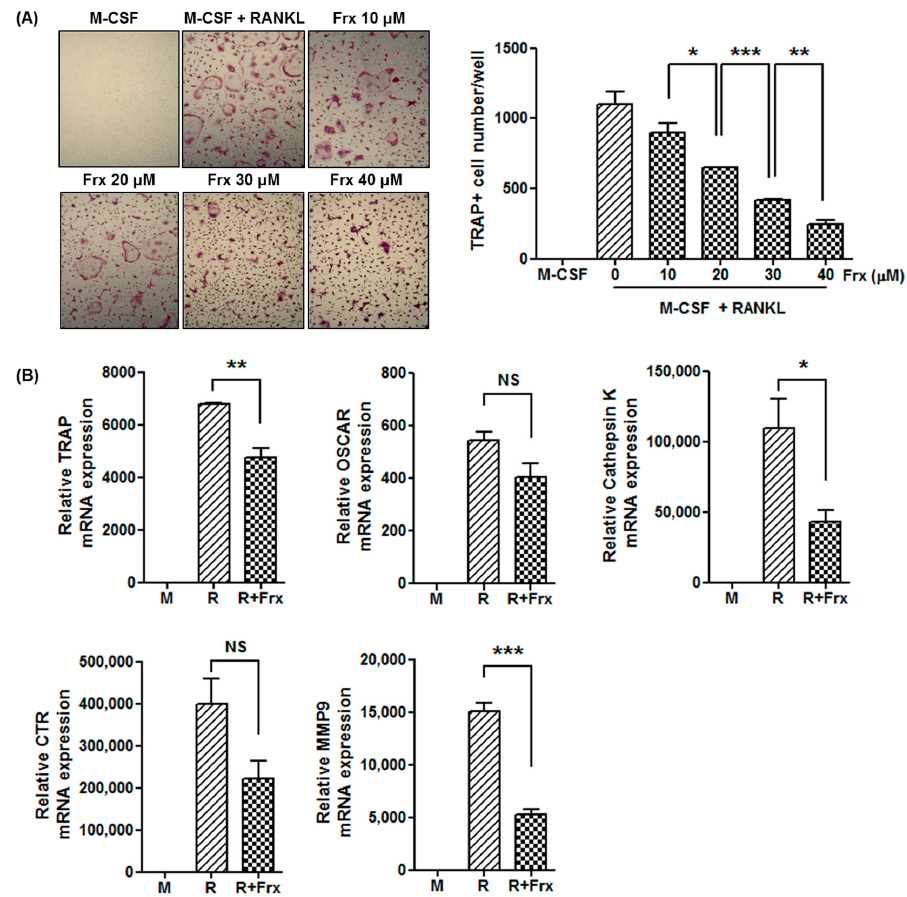
Figure 4. Fraxinellone suppresses murine osteoclastogenesis. ( A ) Murine monocytes obtained from the femur and tibia were cultured with M-CSF and RANKL to induce osteoclatogenesis. TRAP-positive multinucleated cells were counted in the culture dishes at various doses of fraxinellone (original magnification x100). ( B ) The relative mRNA levels of osteoclastogenesis-related markers, such as TRAP , OSCAR , Cathepsin K , CTR , and MMP9 , were evaluated using RT-PCR. Data represent the mean of three independent experiments ± SEM. M-CSF, macrophage-colony stimulating factor;